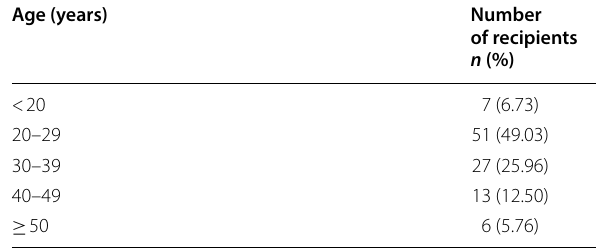
Table 1 Age distribution of the recipient